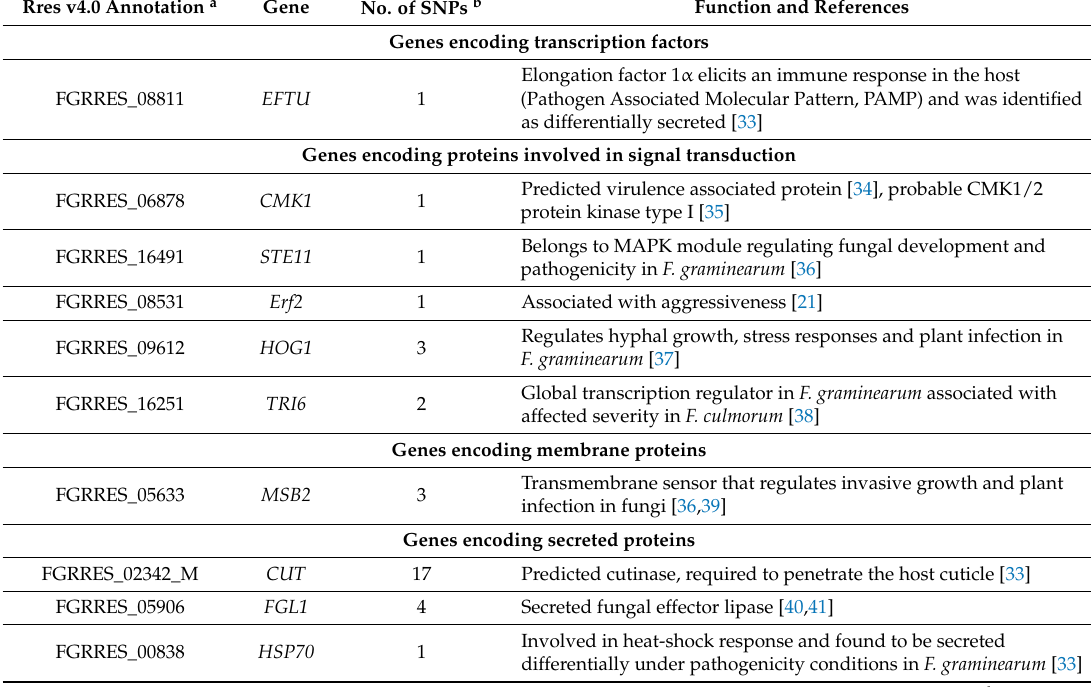
Table 2. Candidate genes under study and number of SNPs with minor allele frequencies >5% [14]. Rres v4.0 Annotation a Gene No. of SNPs b Function and